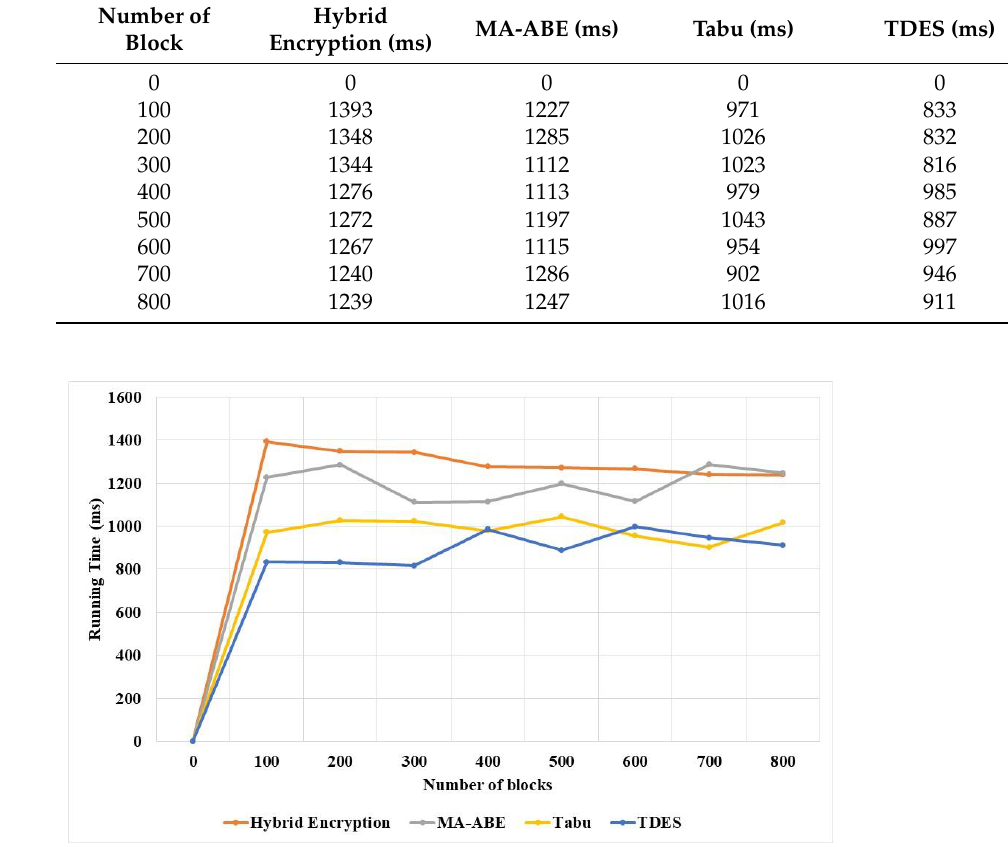
Table 9. Running time of TDES and comparison with existing technique.